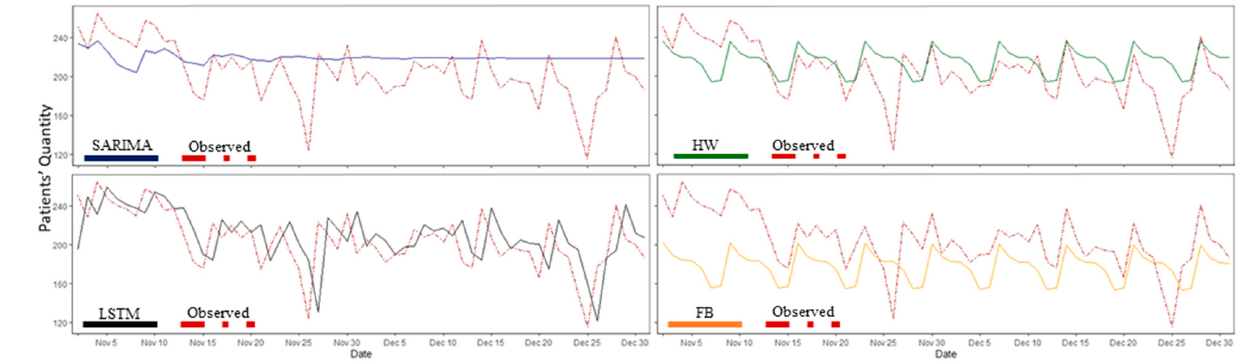
Figure 7. The univariate model predicted values vs. observed data (i.e., test data) for patient arrivals with a one-day forecast horizon. SARIMA: seasonal autoregressive integrated moving average, FP: Facebook Prophet, HW: Holt–Winters, and LSTM: Long Short-Term Memory. Table 3. RMSE and MAE values for univariate models in five different forecasting horizons. Forecasting Horizon (in Models